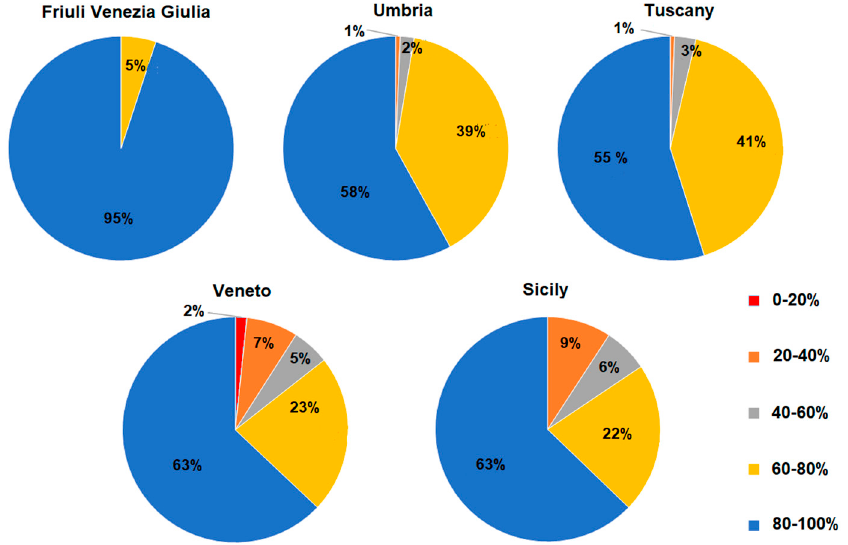
Figure 7. Classification by l.m. of the top five regions.